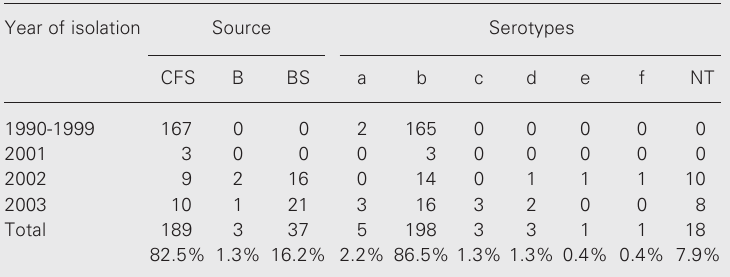
Table 1. Frequency distribution of source of isolates and serotypes of 229 Haemophi- lus influenzae strains isolated from 1990 to